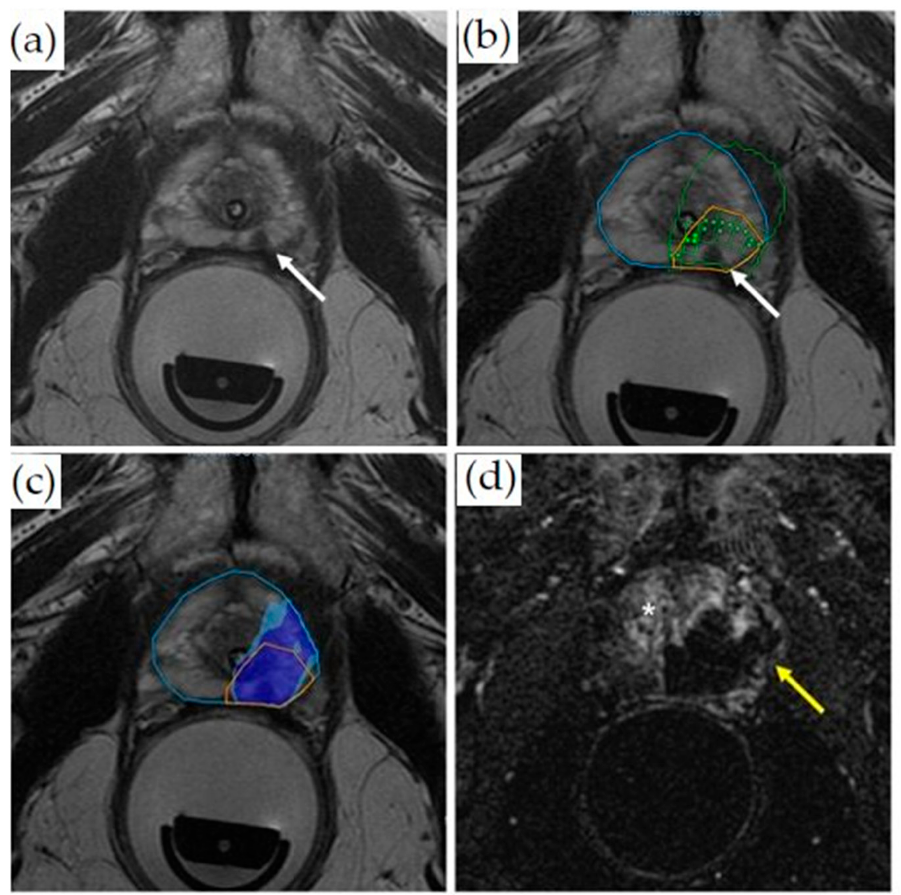
Figure 4. Treatment of a patient with Gleason 3 + 4 PCa with transrectal MR-guided HIFU (ExAblate 2100 device): ( a ) Pretreatment axial T2-weighted MR imaging demonstrates a hypointense lesion in the medial left peripheral zone (white arrow). ( b ) Overlayed treatment planning image shows the prostate contour (blue contour), region of interest with at least 5 mm margins (orange contour), focal spots (green dots inside rectangles), predicted thermal dose (green contour), and lesion (white arrow). ( c ) Thermal map overlay image demonstrates areas that have reached thermal dose based on intraoperative thermometry (dark blue at least 8000 CEM43, light blue 240 CEM43). ( d ) Axial post-contrast images obtained immediately after treatment demonstrate a non-perfused area (dark area, yellow arrow) indicating treatment. The viable prostate tissue demonstrates enhancement (bright signal, asterisk).